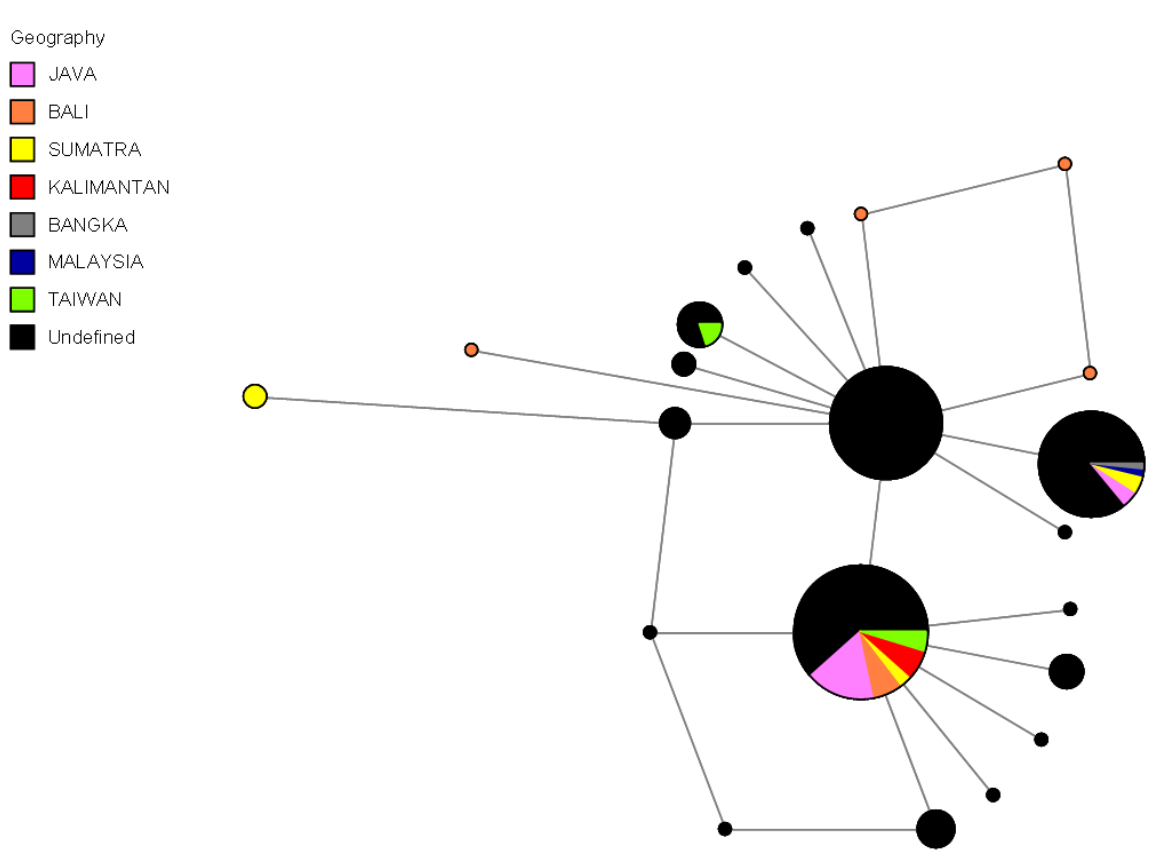
Fig. 2. Minimum spanning network depicting relationships among 16S haplotypes of Fejervarya cancrivora (Gravenhorst, 1829). The size of each circle is proportional to the haplotype frequency and the lengths of the connecting lines are proportional to the number of mutations. Colors refer to distinct regions (Indonesia: Java, Sumatra, Bali, Kalimantan, Bangka; Malaysia; Taiwan) and commercialized frogs of unknown origin are in